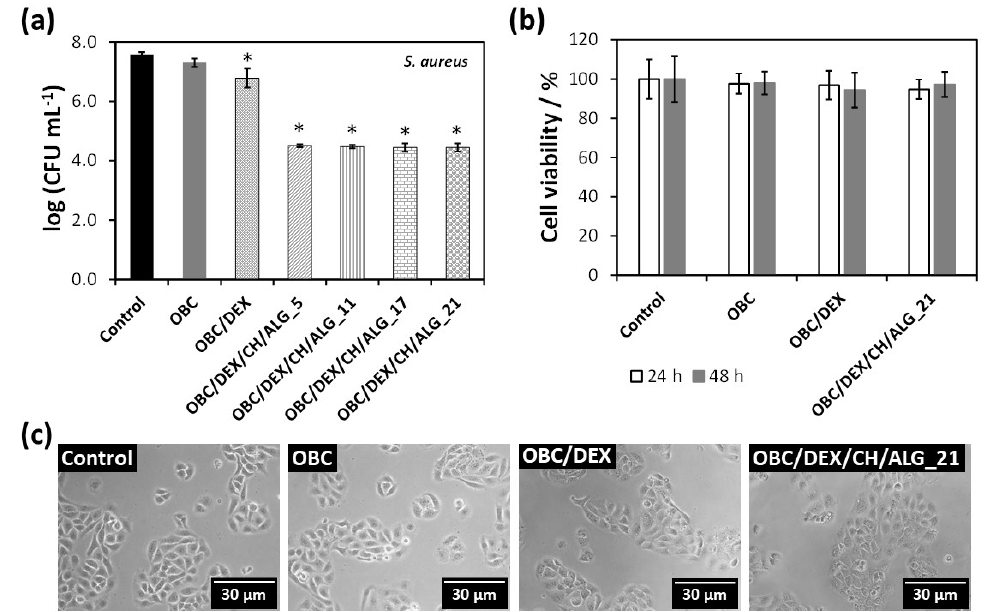
Figure 5. ( a ) Antibacterial activity (24 h of exposure) of OBC, OBC-loaded with DEX, and multi-layered patches (the symbol * represents the means with a significant di ff erence ( p < 0.05) from the control and OBC); ( b ) cell viability of HaCaT cells after 24 h and 48 h of exposure to negative control, OBC, OBC / DEX, and OBC / DEX / CH / ALG_21, and ( c ) the corresponding optical micrographs of HaCaT cells after 24 h of exposure.